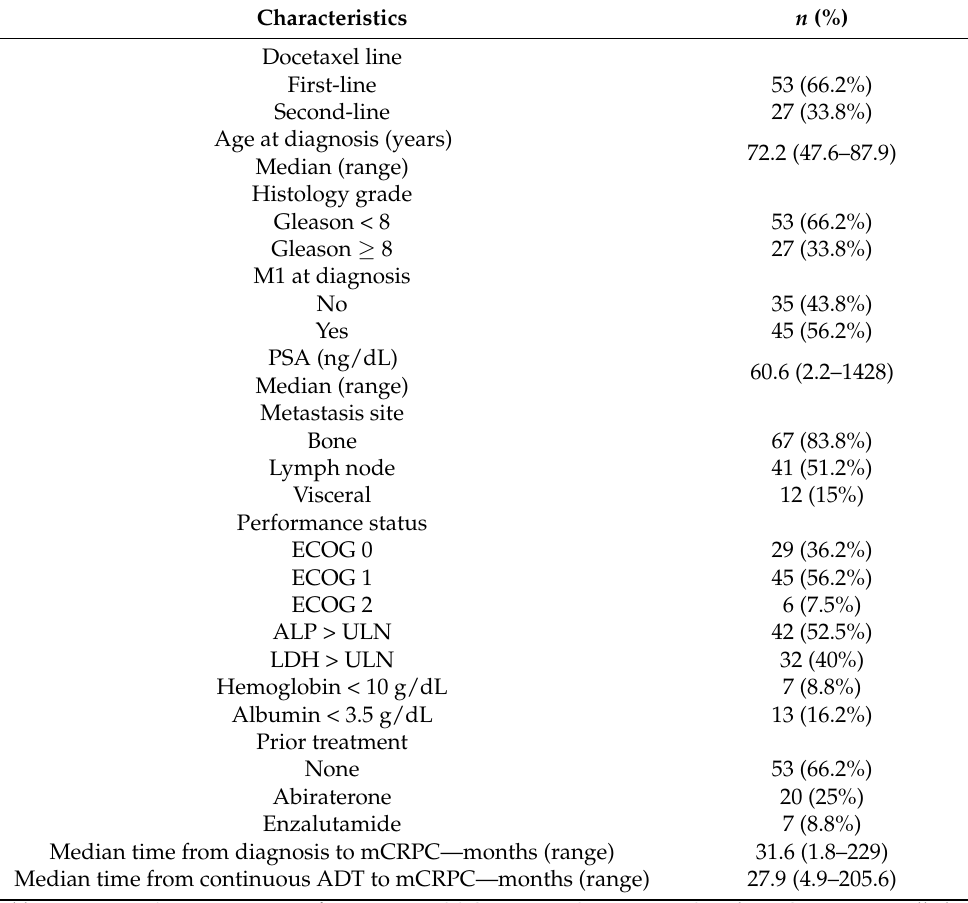
Table 1. Patient characteristics at baseline and